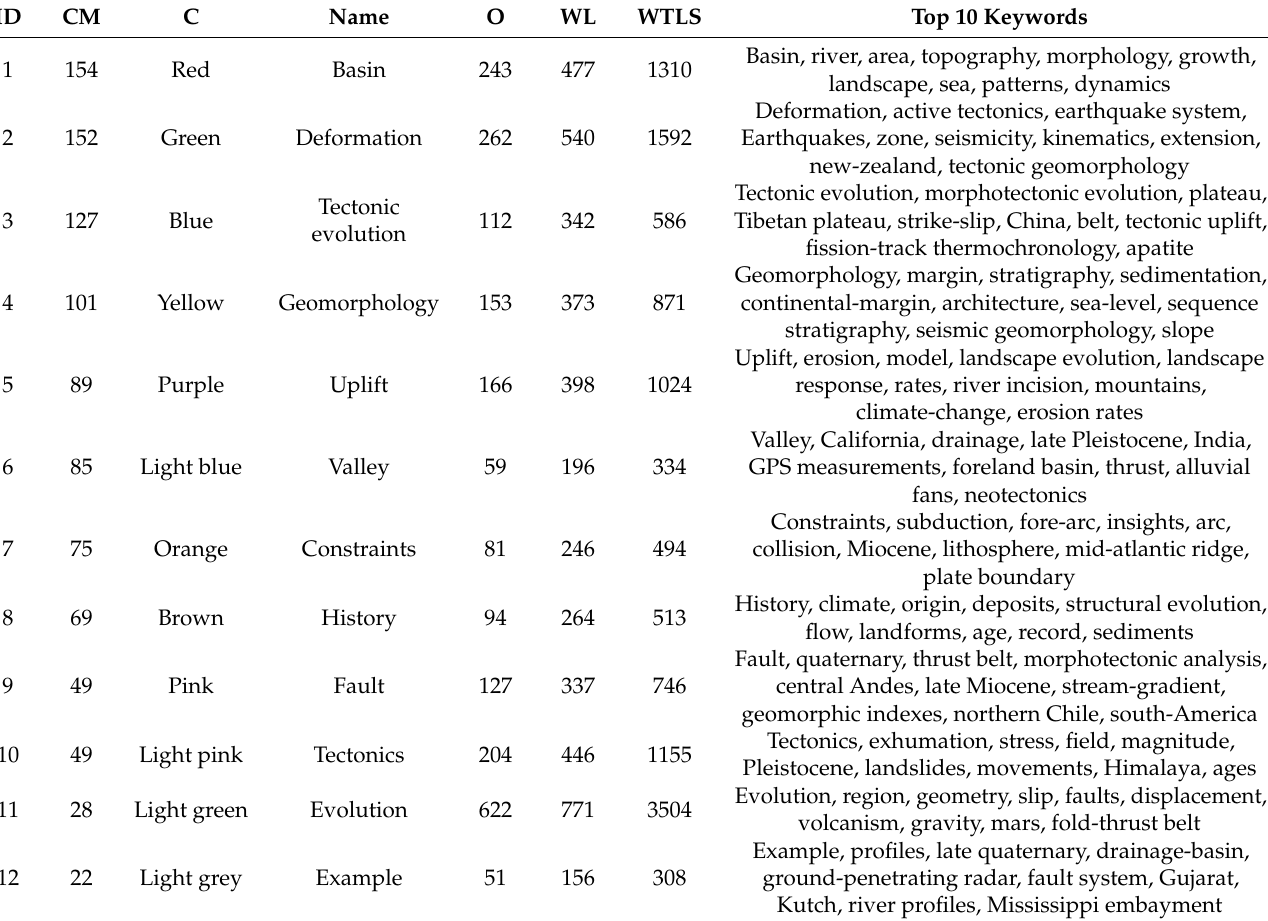
Table 6. Keywords cluster on tectonic geomorphology research in